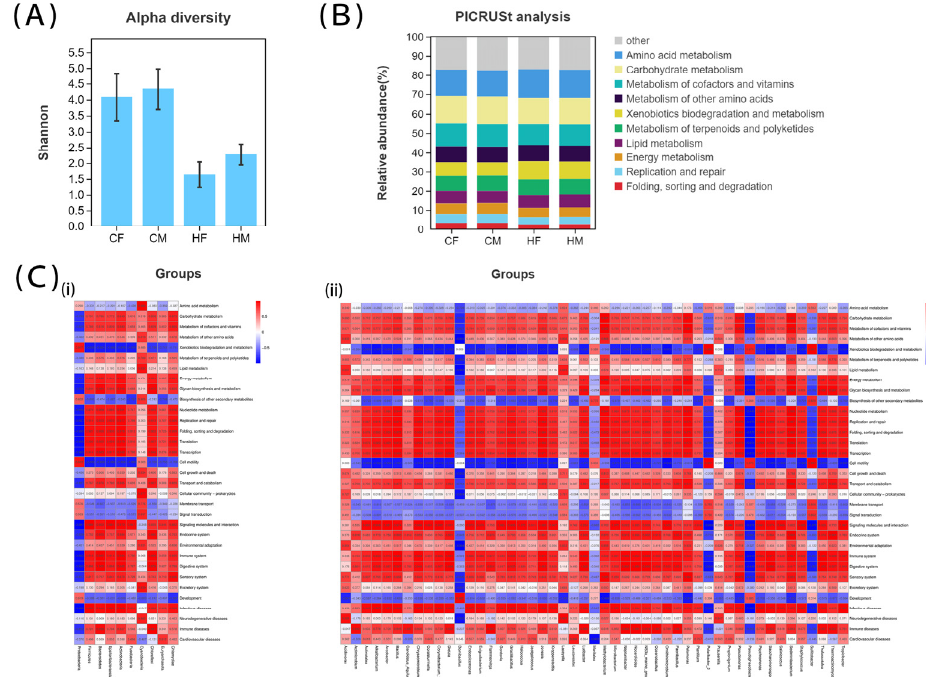
Figure 2. Alpha diversity and function analysis of intestinal microbiota in sea cucumbers. ( A ) Alpha diversity by Shannon index. ( B ) The top ten most enriched microbiota pathways. ( C ) Functional correlation analysis of microbiota that were significantly different between experimental groups [(i): phyla; (ii): genus].